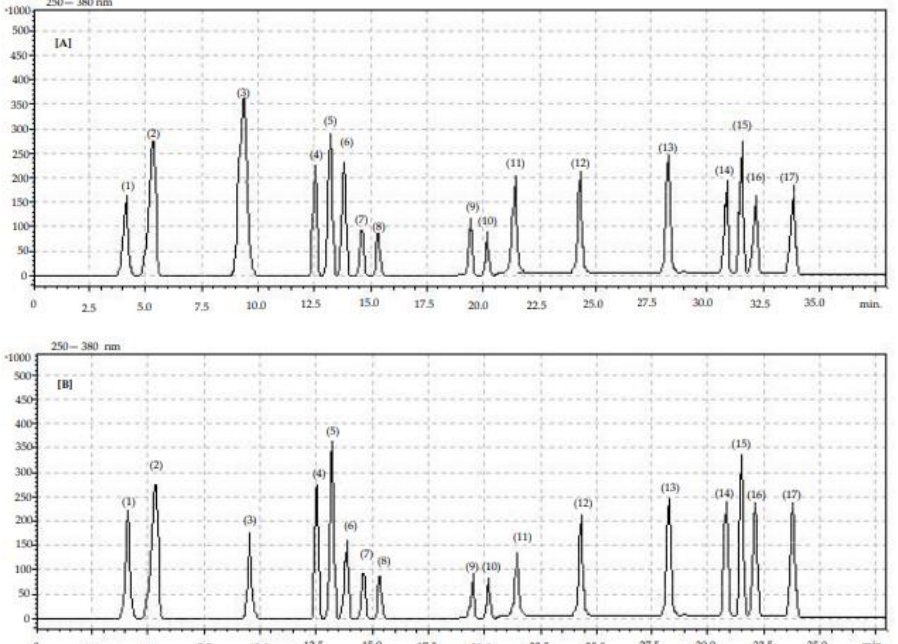
Figure 1. Chromatogram showing retention times for identified phenolic compounds in organic ( A ) and conventional ( B ) blue honeysuckle fruits: (1) gallic acid, (2) phenol unknown, (3) chlorogenic acid, (4) phenol unknown (5) caffeic acid, (6) phenol unknown, (7) phenol unknown, (8) phenol unknown, (9) quercetin-3- O -rutinoside, (10) p-coumaric acid, (11) phenol unknown, (12) kaempferol-3- O -glucoside, (13) myricetin, (14) luteolin, (16) quercetin, (17) kaempferol.